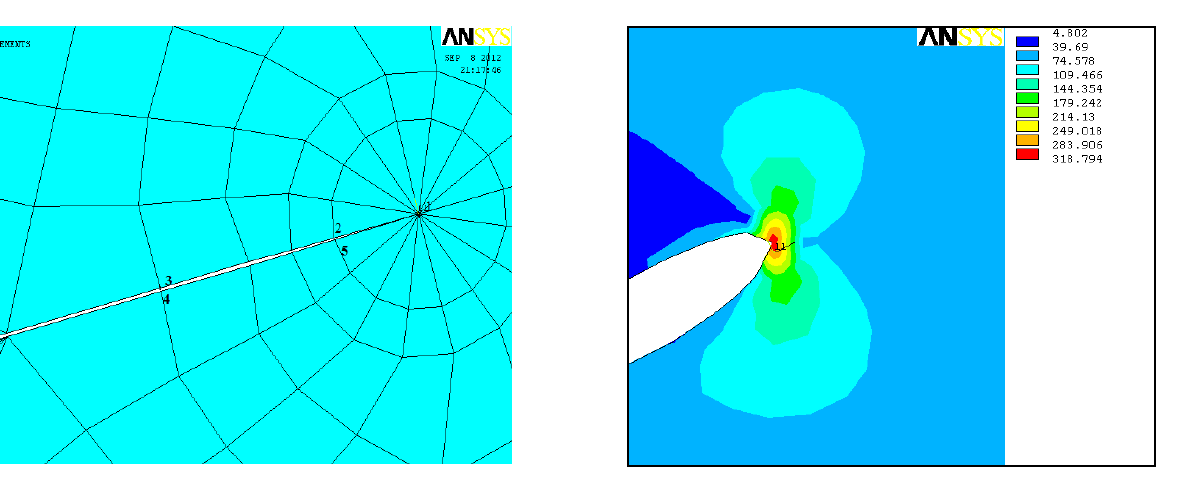
Figure 5: Defining the path node 1-2-3-4-5 for finding SIF. Figure 6: Von Mises stress distribution for inclined cracked in a